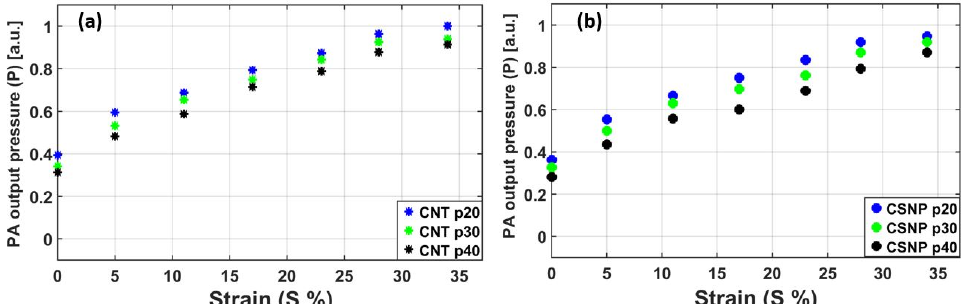
Figure 5. PA output pressure amplitudes measured under various strain conditions for the free- standing nanocomposite transmitters with different nanoparticle concentrations: ( a ) CNT-PDMS, ( b ) CSNP-PDMS.